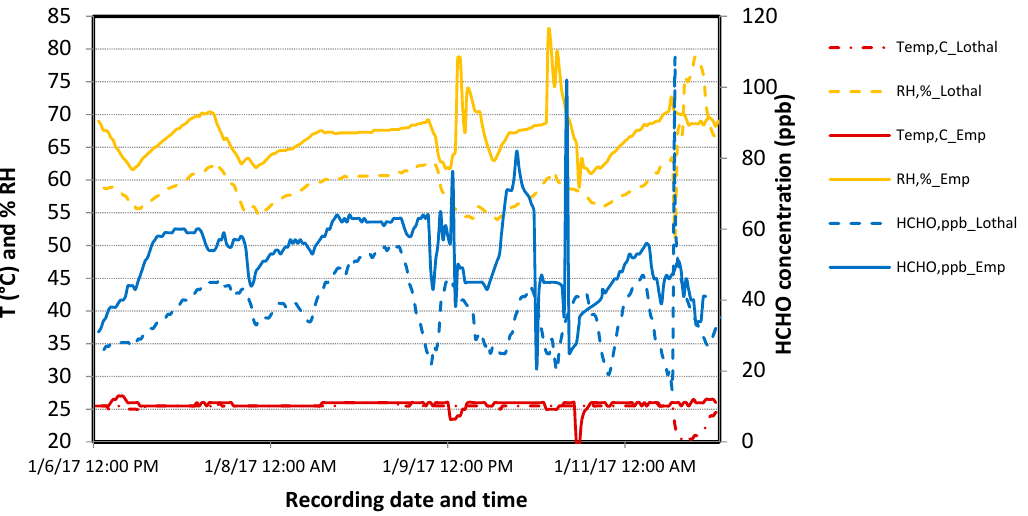
Figure 11. Comparative T, RH, and HCHO concentrations in Lothal and Empire.